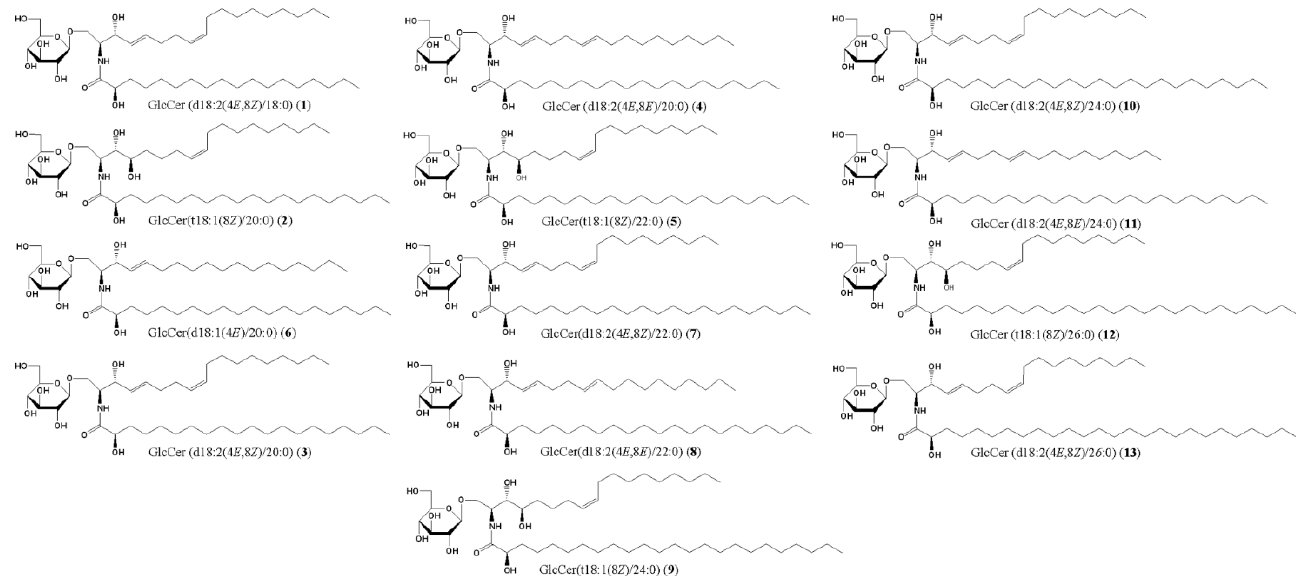
Figure 1. Chemical structures of GlcCer ( 1 – 13 ) isolated from GlcCer-rich rice oil by-product.